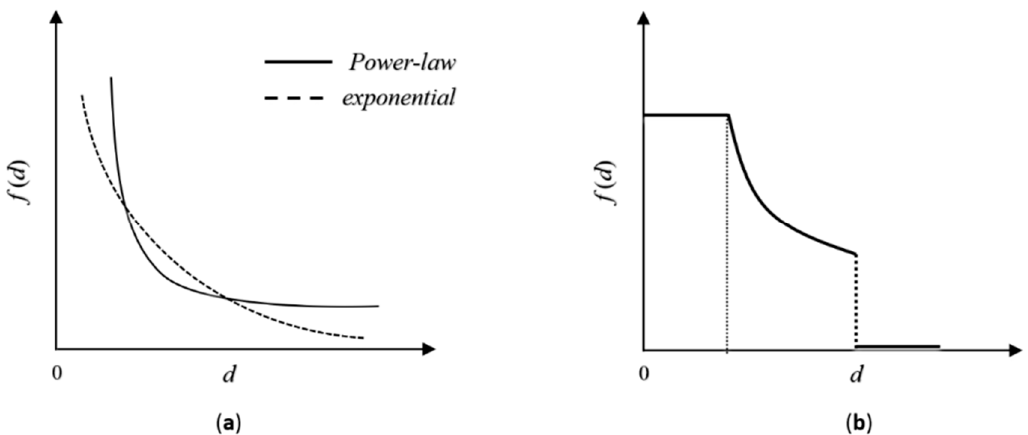
Figure 1. ( a ) Power-law and exponential distance-decay function; ( b ) piecewise distance-decay function.